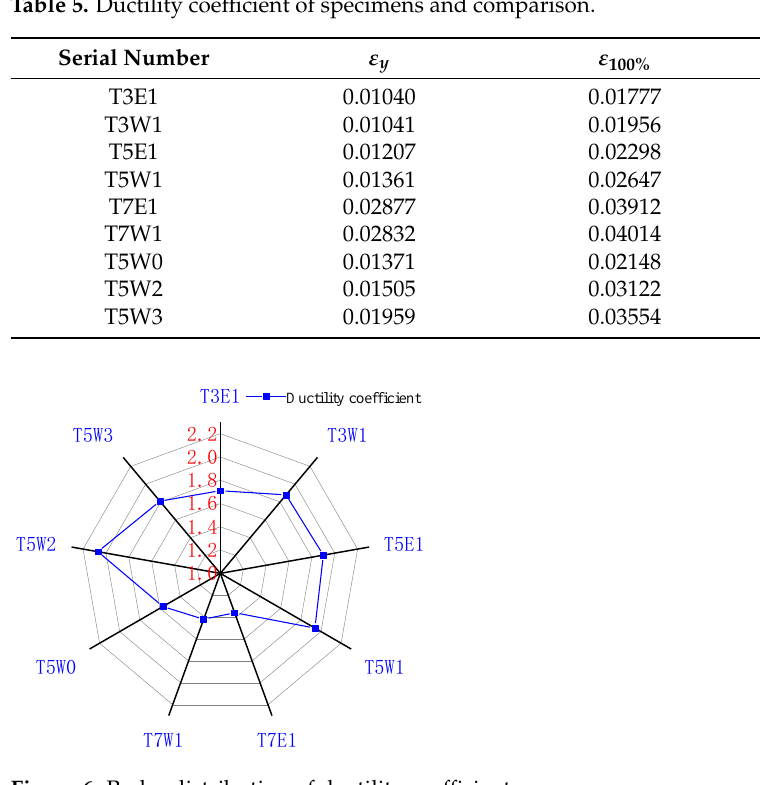
Table 5. Ductility coefficient of specimens and comparison.